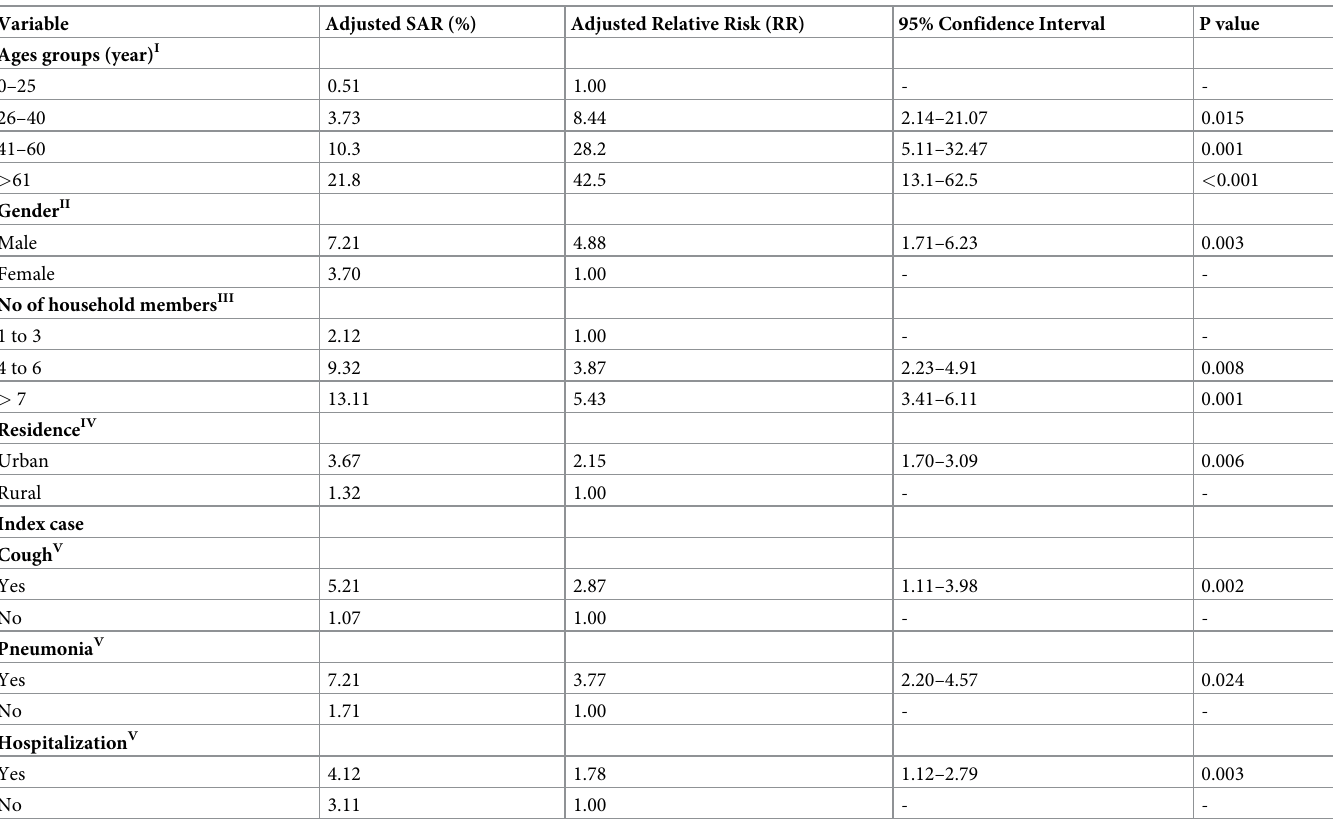
Table 3. Relative risk and adjusted SARs of COVID-19 secondary case using an inverse probability weighting in Pakistani household